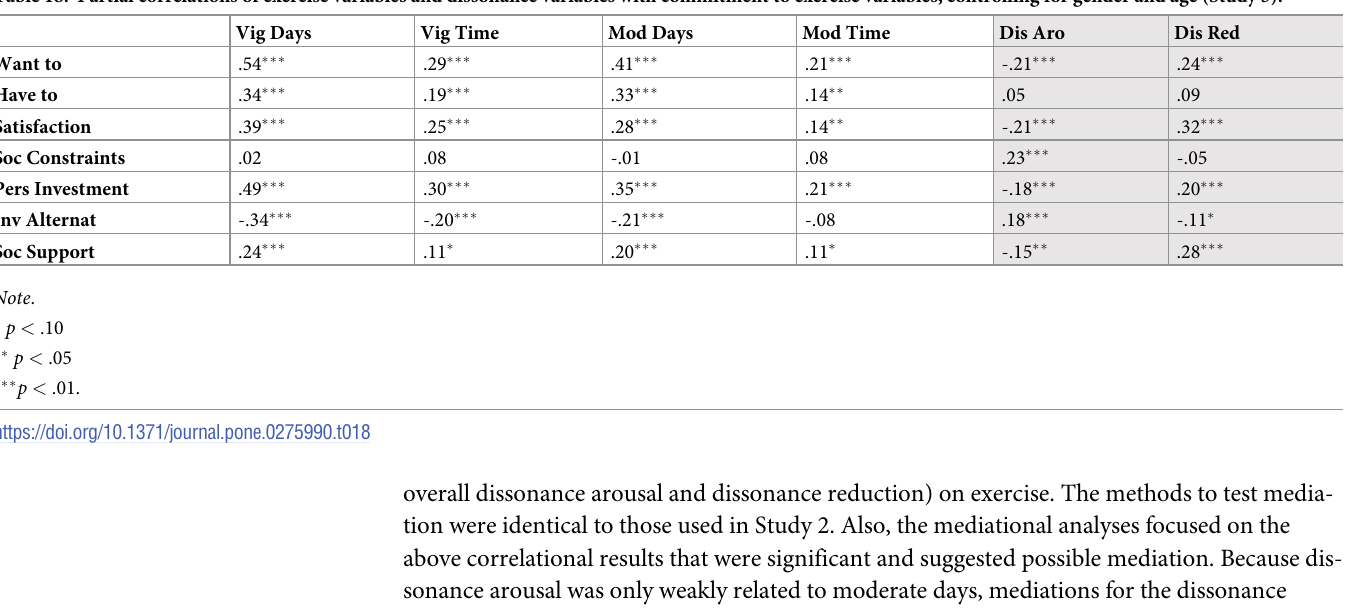
Table 18. Partial correlations of exercise variables and dissonance variables with commitment to exercise variables, controlling for gender and age (Study